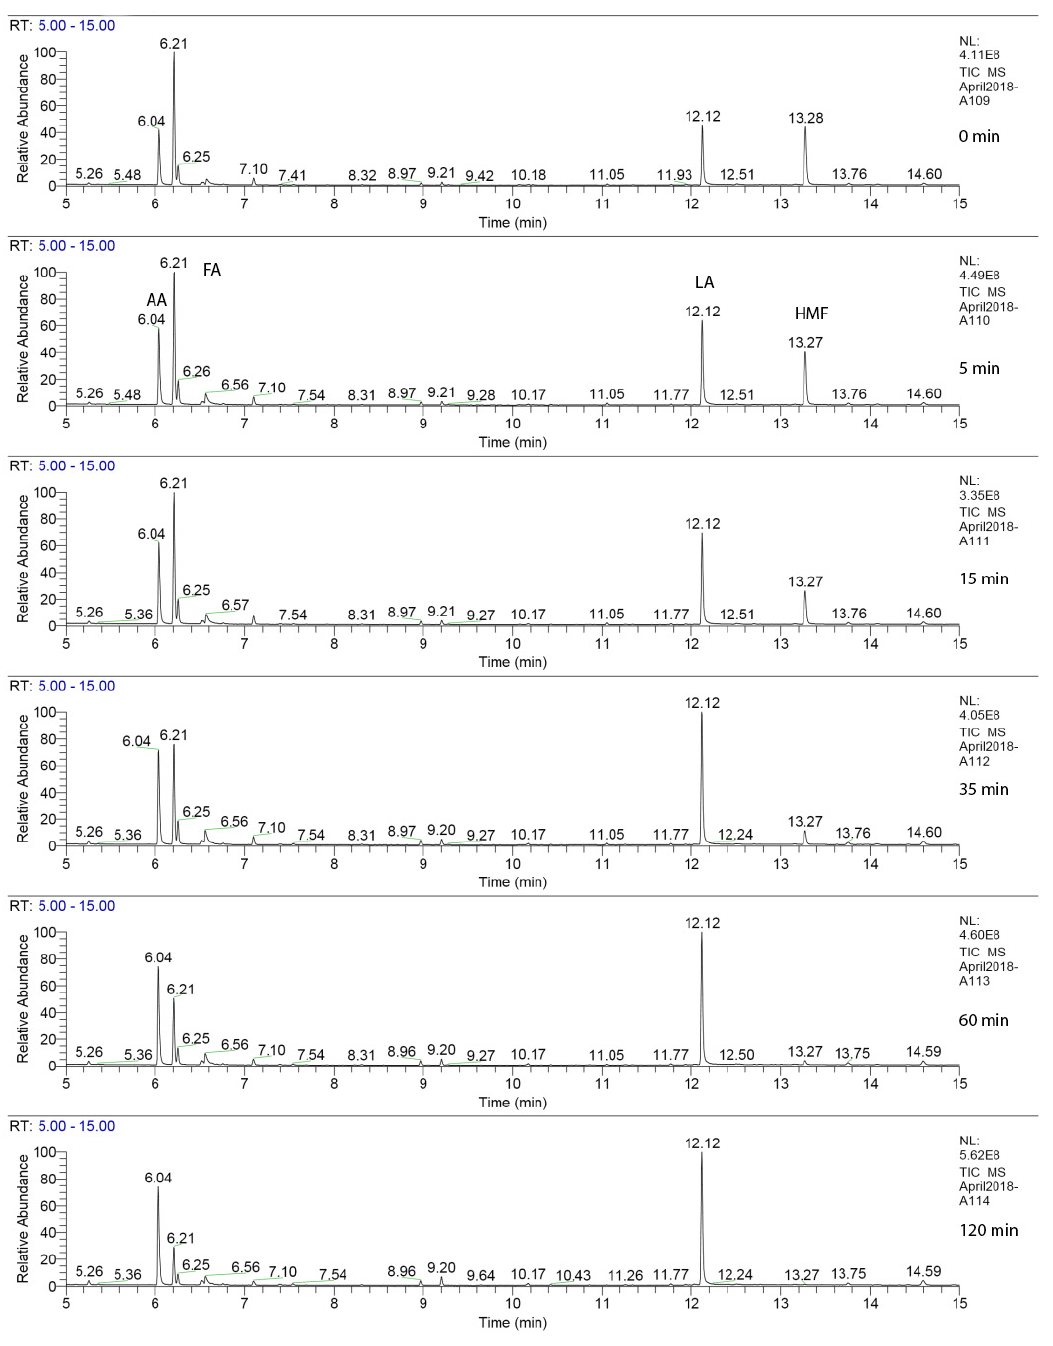
Figure 8. Total ion chromatograms process solution from HTP process as a function of time. The HTP catalyst concentration was 2 g / L. Acetic acid (AA) at 6.04 min, formic acid (FA) at 6.21 min, levulinic acid (LA) at 12.13 min, and 2,5-hydroxymethyl furfuraldehyde (HMF) at 13.27 min retention time.